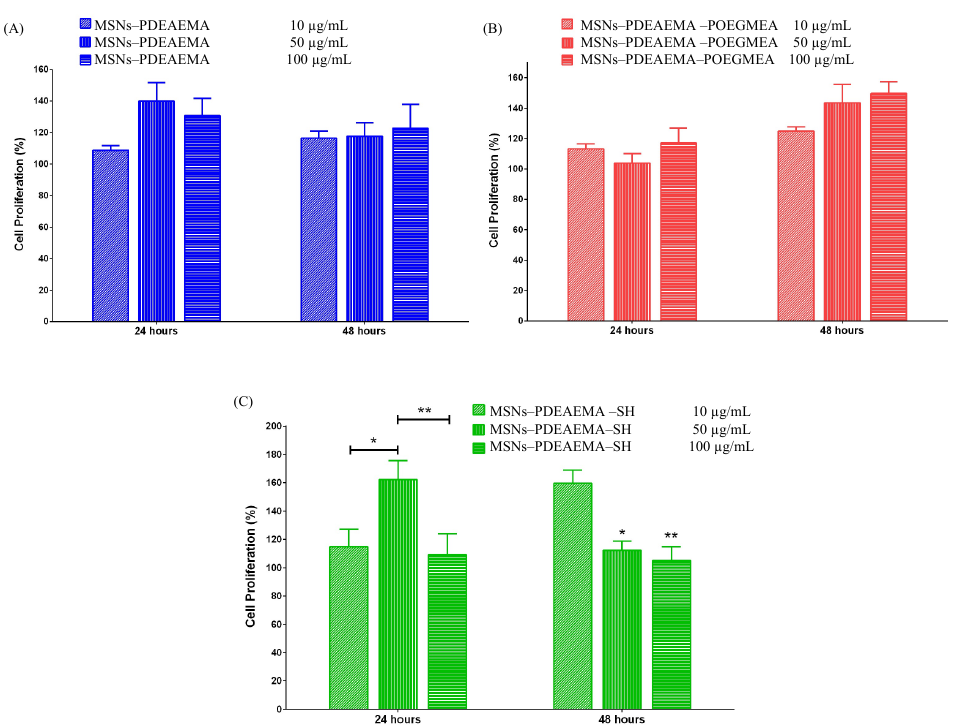
Figure 7. Cell viability of human bone marrow-derived mesenchymal stem cells (hMSCs) after exposure to the selected nanosystems. Cells were exposed for 24 h and 48 h to 10, 50, and 100 µg/mL of: ( A ) MSNs–PDEAEMA, ( B ) MSNs–PDEAEMA–POEGMEA, and ( C ) MSNs–PDEAEMA–SH. Astride indicate the level of significance as follows: * P > 0.05, ** P > 0.01.